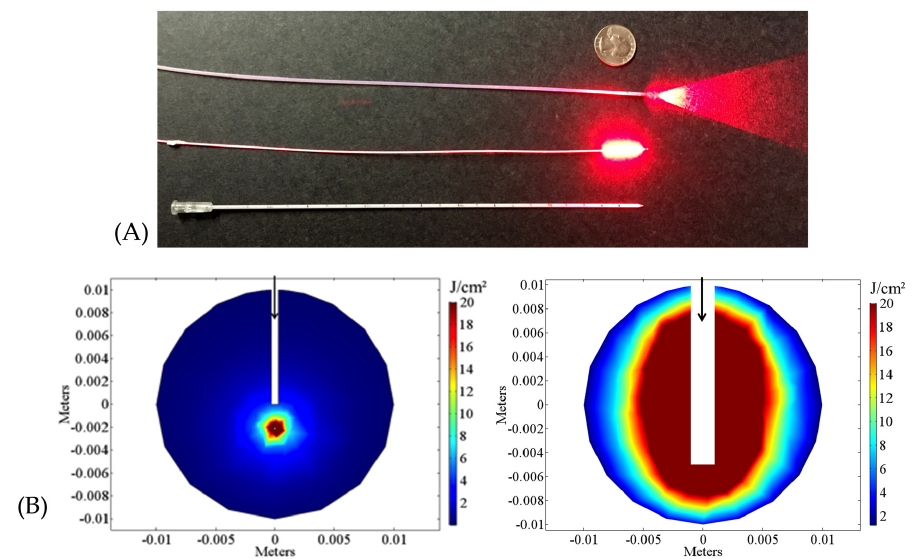
Figure 1. Laser treatment fibers. ( A ) A typical 600-µm-diameter flat-cut (top), a 0.98-mm-diameter 1-cm cylindrical diffuser fiber emitting red laser light (middle), and an optically transparent plastic catheter with a 2-mm-outer diameter and a 1.45-mm-inner diameter (bottom) that can be used for insertion of cylindrical diffusers [10]; ( B ) Computer simulation of light propagation from a flat-cut fiber (bottom left), and a 1-cm cylindrical diffuser (bottom right) in a catheter. The black arrows point to the location of the fibers in a 2-cm-diameter spherical geometry with optical properties set to be similar to those measured for 652-nm light in a head and neck tumor by Robinson et al. [12]. A detailed description